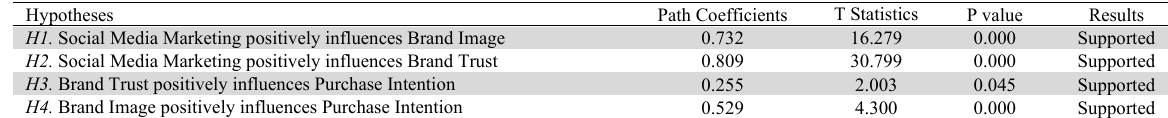
Results of Model Test